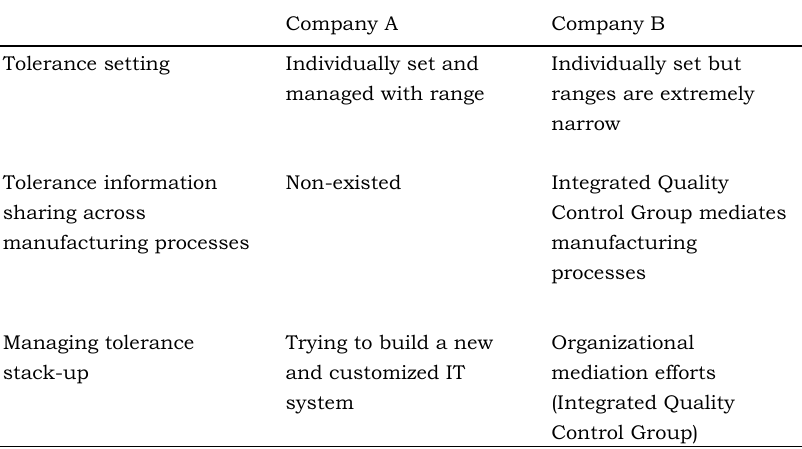
Table 2. Tolerance management in Companies A and